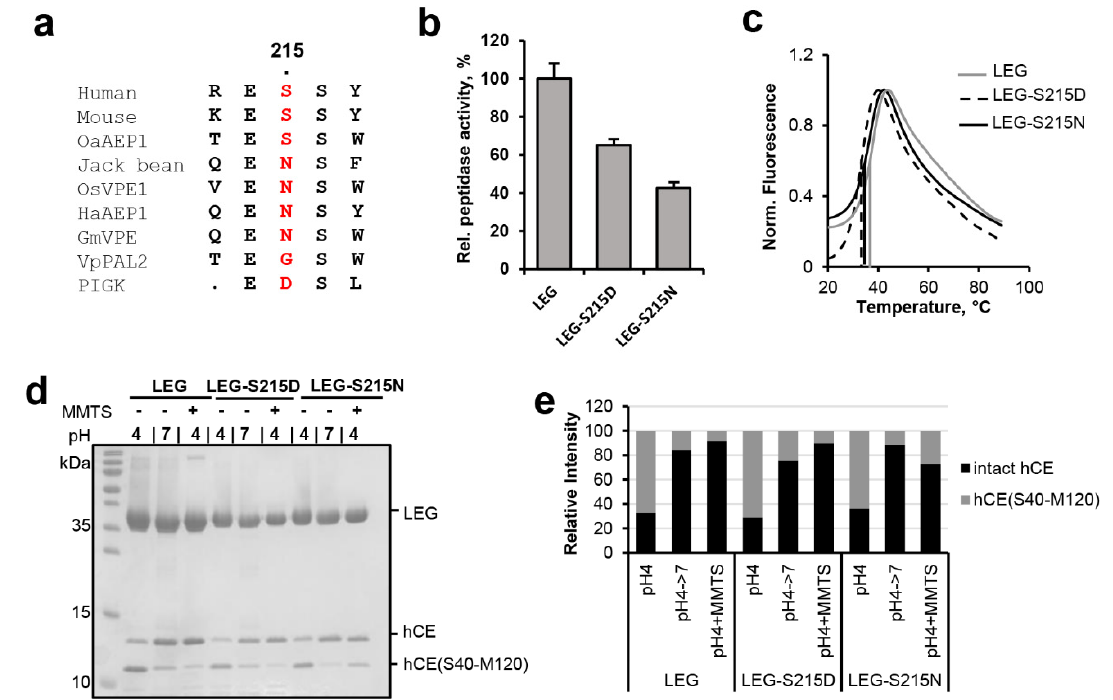
Figure 4. Ser215 is enhancing legumain protease activity towards peptidic substrates. ( a ) Sequence alignment of human, mouse, jack bean, O. sativa (rice), and H. annuus (sunflower) legumain and the PIGK protein (phosphatidylinositol glycan anchor biosynthesis class K protein, part of the glycosylphosphatidylinositol transamidase complex). Residue 215 (human legumain numbering) is highlighted in red. Uniprot IDs of the sequences used are specified in the material and methods section. ( b ) Relative activity of wild-type legumain (LEG), and the legumain-S215N and -S215D mutants measured as turnover of the AAN-AMC substrate at pH 5.5. ( c ) Thermal unfolding of wild-type (LEG), S215A- and S215D-legumain variants (LEG-S215A and LEG-S215D), measured at pH 6.0. ( d ) Incubation of legumain with cystatin M/E (hCE) at pH 4.0 led to processing of cystatin M/E after the P1-Asn39 residue. The C-terminal cleavage product hCE(S40-M120) is indicated. Subsequent incubation at pH 7.0 or addition of S-methyl methanethiosulfonate (MMTS) led to resynthesis of the intact cystatin M/E by re-ligation of the Asn39-Ser40 peptide bond. MMTS leads to a covalent thiomethylation of the catalytic Cys189. ( e ) Bands corresponding to intact cystatin M/E and to the C-terminal cleavage product hCE(S40-M120) shown in ( d ) were quantified using